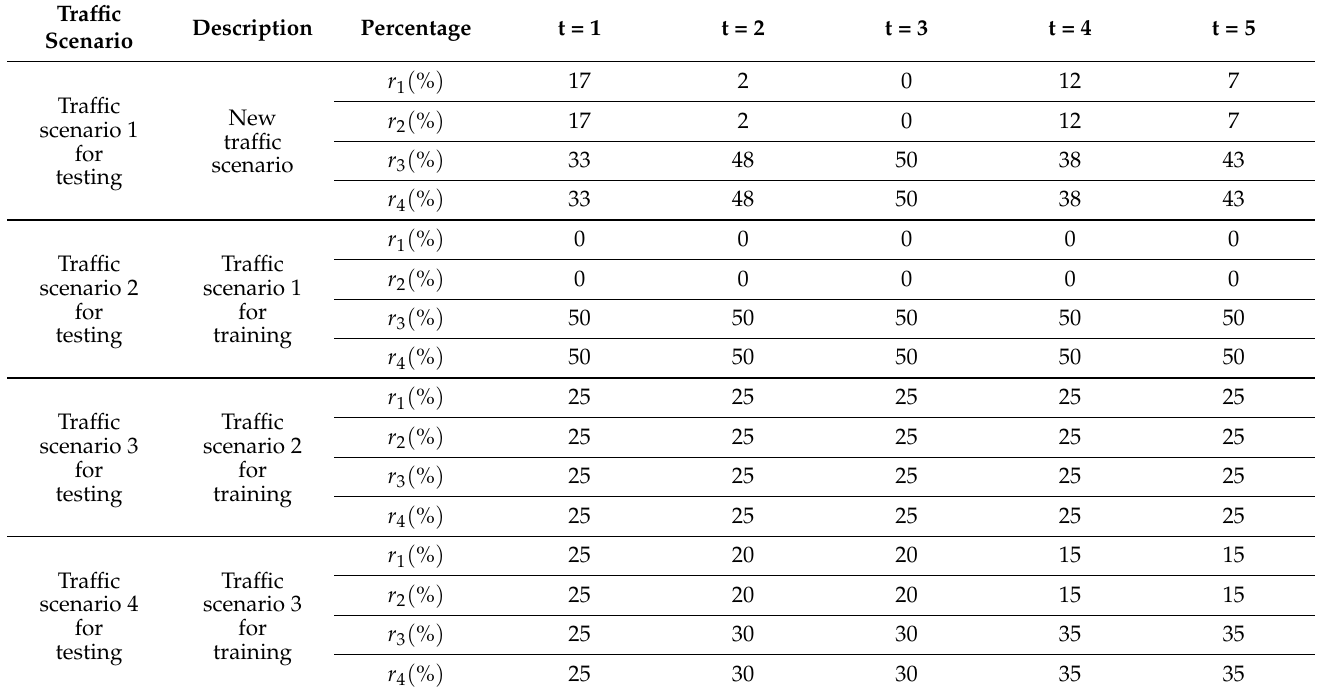
Table 9. Design of traffic scenarios for testing: allocation of vehicles in each direction.